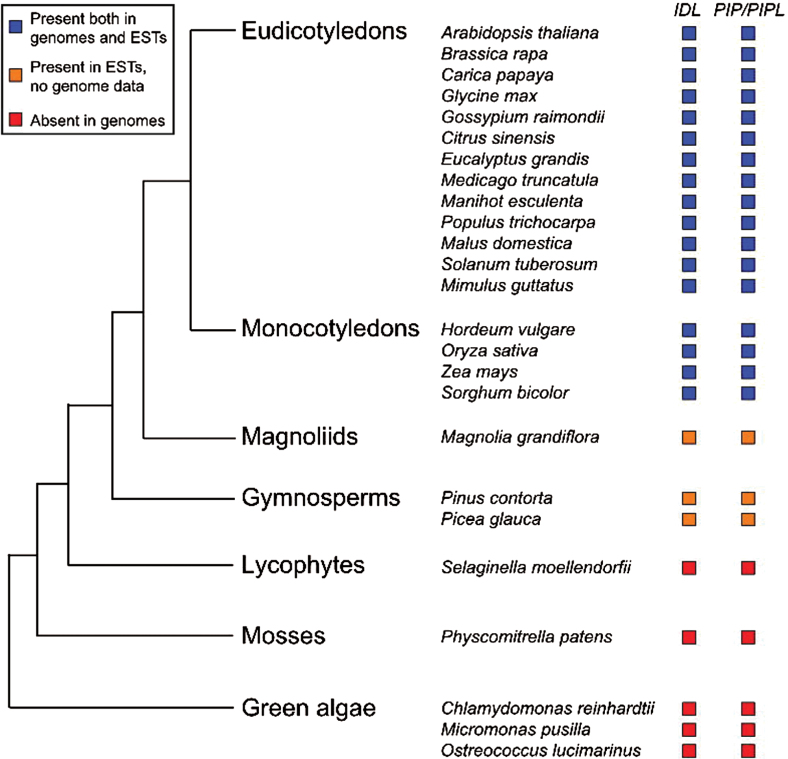
Distribution of IDA/IDL and PIP/PIPL genes within Viridiplantae. The conserved C-terminal domain of IDA/IDL and PIP/PIPL proteins were used in TBLASTN searches against the NCBI (genomes and ESTs), Phytozome v9.1 (genomes) and OneKP (ESTs) databases. The tree was adapted from Phytozome (Goodstein et al., 2012) and Delay et al. (2013).